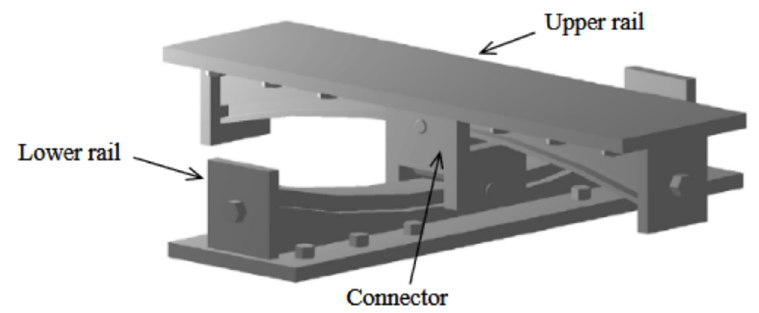
Figure 8. Schematics of a XY-FP [72].